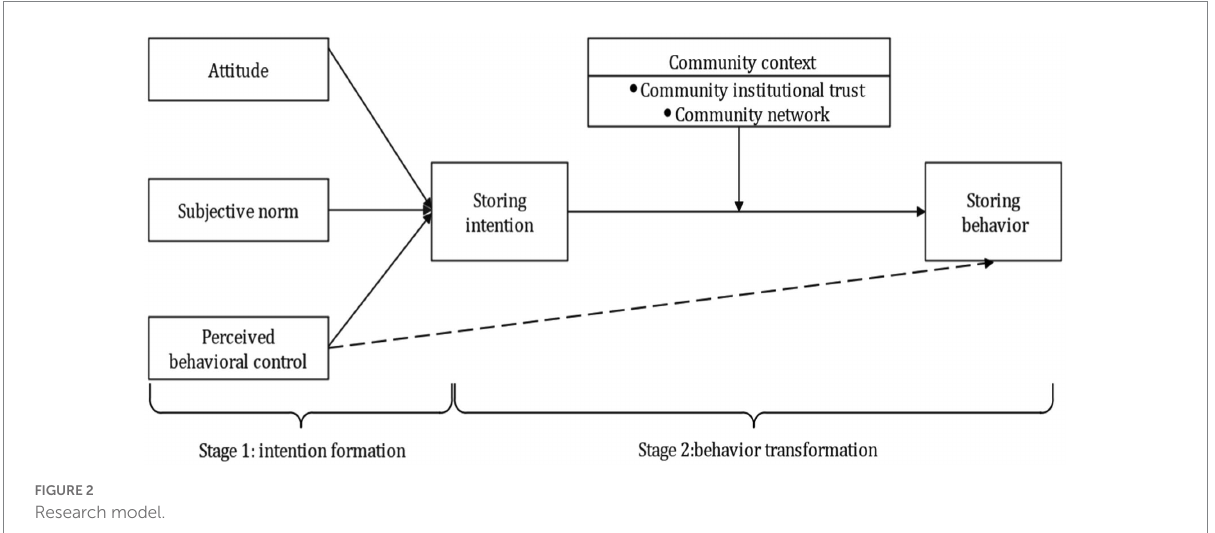
FIGURE 2 Research